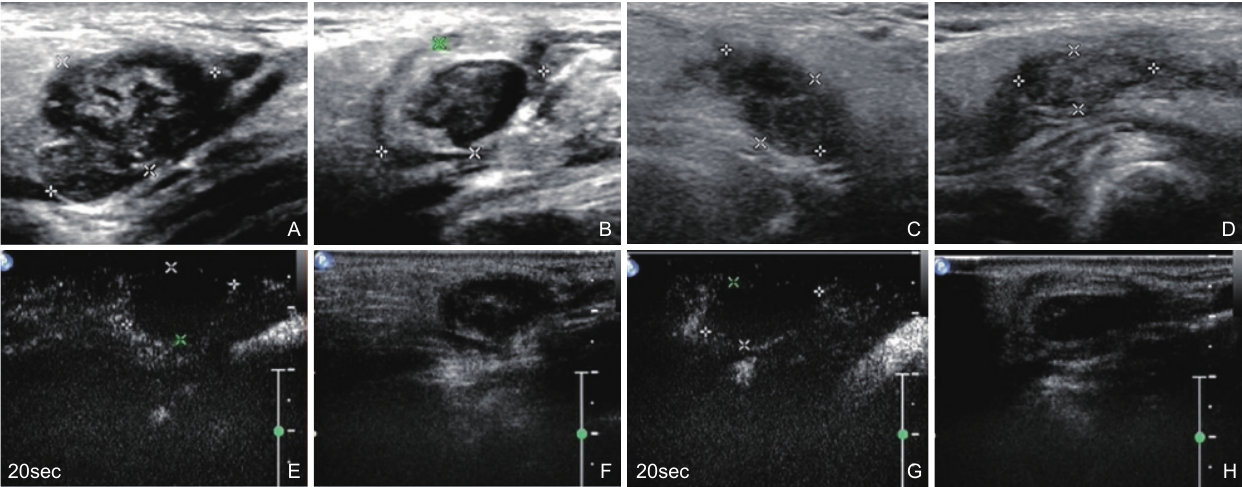
Figure 3 Follow-up of the patient after MWA. (A, B) One month after MWA, the volume of the right parotid nodule shrank to 1.9cm × 1.4cm × 1.2cm and the left shrank to 1.7cm × 1.2cm × 1.1cm with a well-defined margin; (C, D) Six months after MWA, the volume of the right parotid nodule shrank to 1.3cm× 0.8cm×0.7cm and the left shrank to 1.3cm×0.6cm×0.5cm; (E, F, G, H) One month after MWA, contrast-enhanced US showed no enhancement in the bilateral nodules.